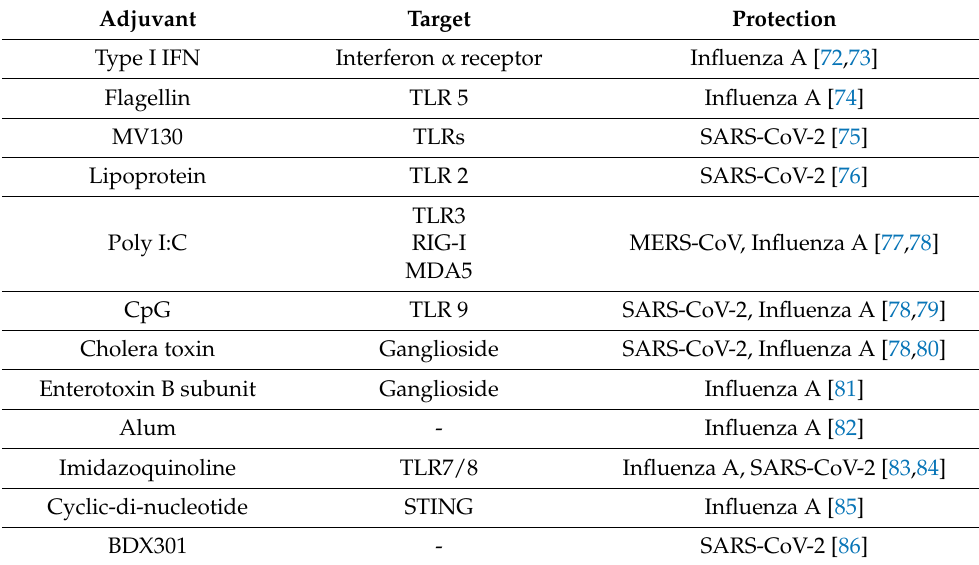
Table 1. Intranasal vaccine adjuvants of IgA production against respiratory pathogens. Adjuvant Target Protection Type I